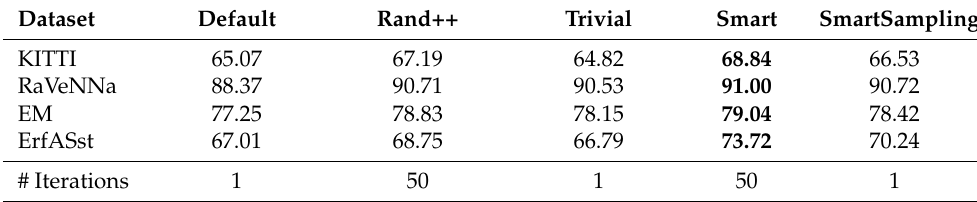
Table 1. Test mean Intersection over Union (IoU) in percentage for different algorithms on semantic segmentation datasets. SmartAugment outperforms all other data augmentation strategies across all datasets. SmartSamplingAugment competes with the previous state-of-the-art approaches and outperforms TrivialAugment, a comparably cheap method. For DefaultAugment, TrivialAugment, and SmartSamplingAugment, we evaluated each experiment three times using different seeds to obtain the mean performance. For RandAugment++ (an extended version of RandAugment) and SmartAugment, we took the mean test IoU over the three best performing validation configurations. Please note that DefaultAugment represents the baseline, and the higher the value, the better the performance. # iterations refers to the number of BO iterations completed to find best